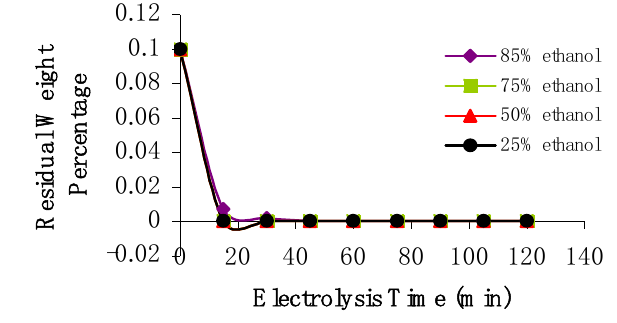
Figure 8. Plot of the residual weight percentage and electrolysis time for 0.1% w/v tannin at 275 nm ; (cid:122) , 25% ethanol , ▲ , 50% ethanol, (cid:132) , 75% ethanol and (cid:139) , 85% ethanolic solution.